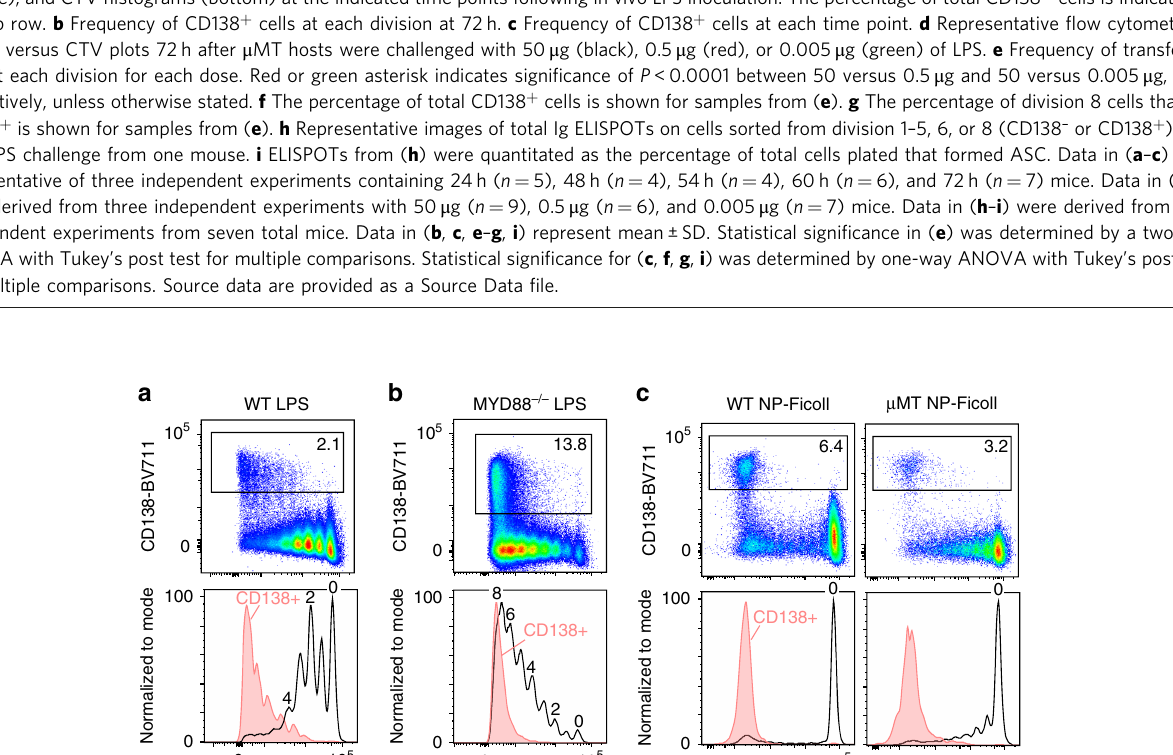
Fig. 2 T-independent type I and II antigens reveal similar division requirements. Representative fl ow cytometry of CD138 versus CTV plots (top) and CTV histograms (bottom) 72 h post immune challenge for a WT hosts challenged with 50 μ g of LPS; b MYD88 – / – hosts challenged with 50 μ g of LPS; c WT hosts (left) or μ MT hosts (right) challenged with 50 μ g of NP-Ficoll. Black CTV histograms represent distribution of total transferred cells, while solid red CTV histograms represent CD138 + cells. Gating and percentage of CD138 + cells are indicated in the top row. Data in ( a , c ) for WT hosts are representative examples from three independent experiments and six total mice each. Data in ( b ) are representative of two independent experiments with six total mice. Data in ( c ) for μ MT host are representative of two independent experiments with six total